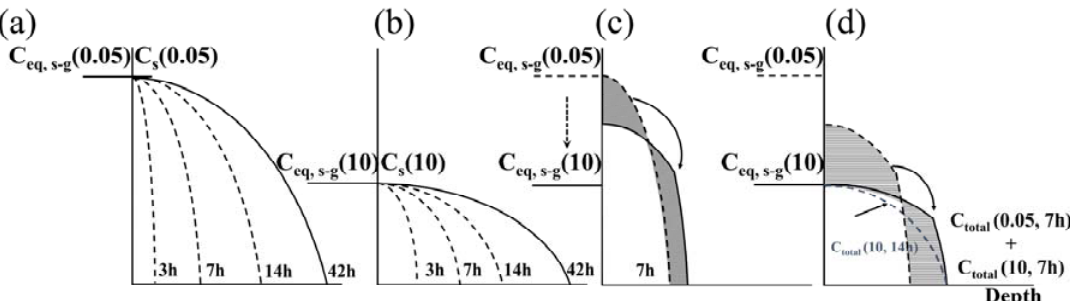
Figure 7. Schematic illustrations of the carbon concentration profiles at gas ratio of ( a ) 0.05 and ( b ) 10, and the variance of the profile due to the difference of the para-equilibrium carbon concentration when the gas ratio was changed from 0.05 to 10: ( c ) the step in which the carbon atoms on the surface side diffused toward the substrate, and ( d ) the step where the surface carbon concentration and the para-equilibrium carbon concentration at gas ratio of 10 are